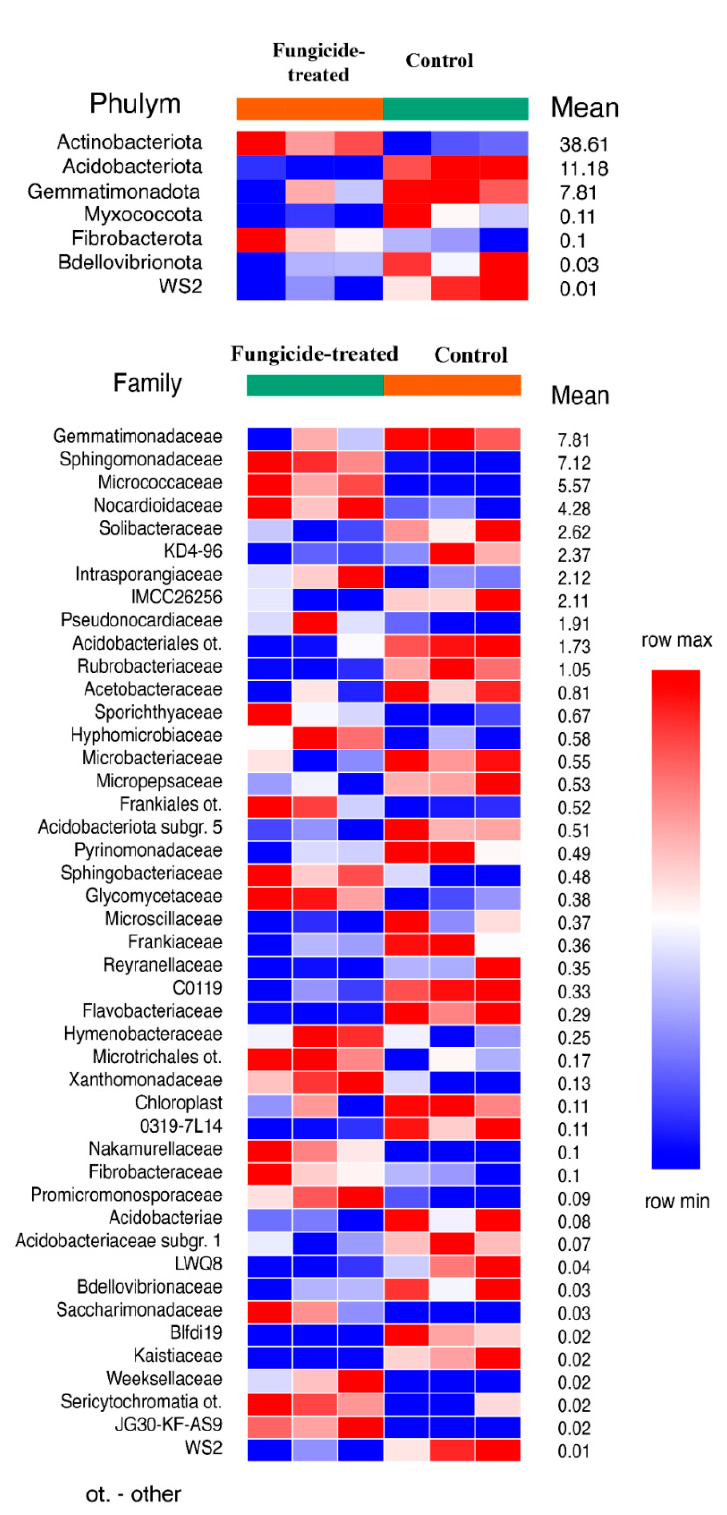
Figure 1. The relative abundance of bacterial phyla and families ranked by their relative abundance. The data represent means of three replicate sequencing reactions, and each reaction was based on pooled DNA samples from three biological replicates ( p < 0.05).